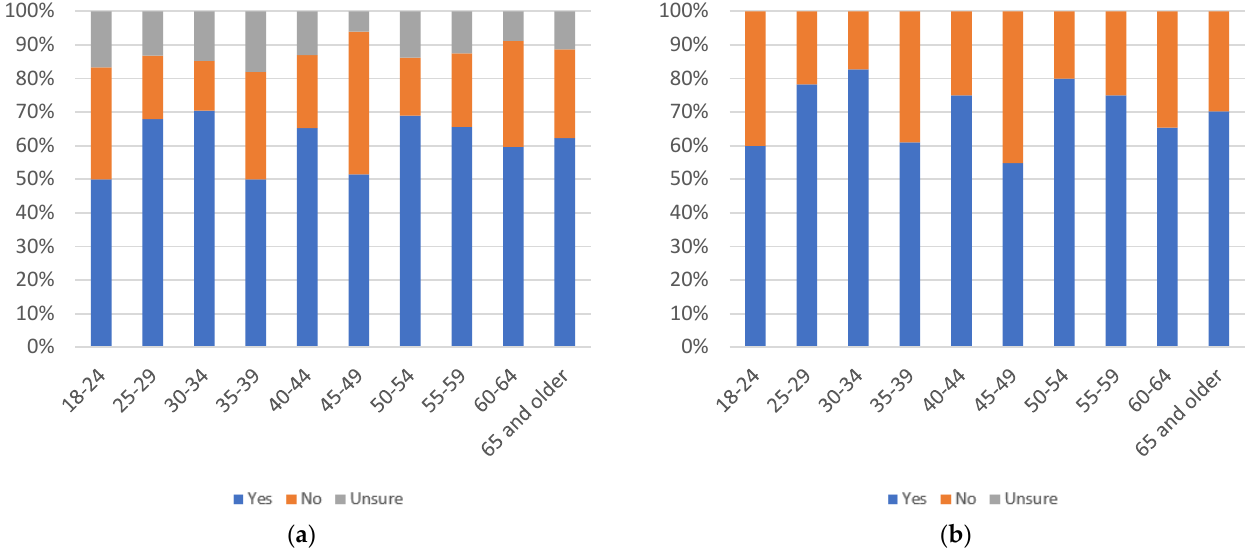
Figure 75. Label use, by age group: ( a ) with uncertain respondents (left) and ( b ) without uncertain respondents (right).